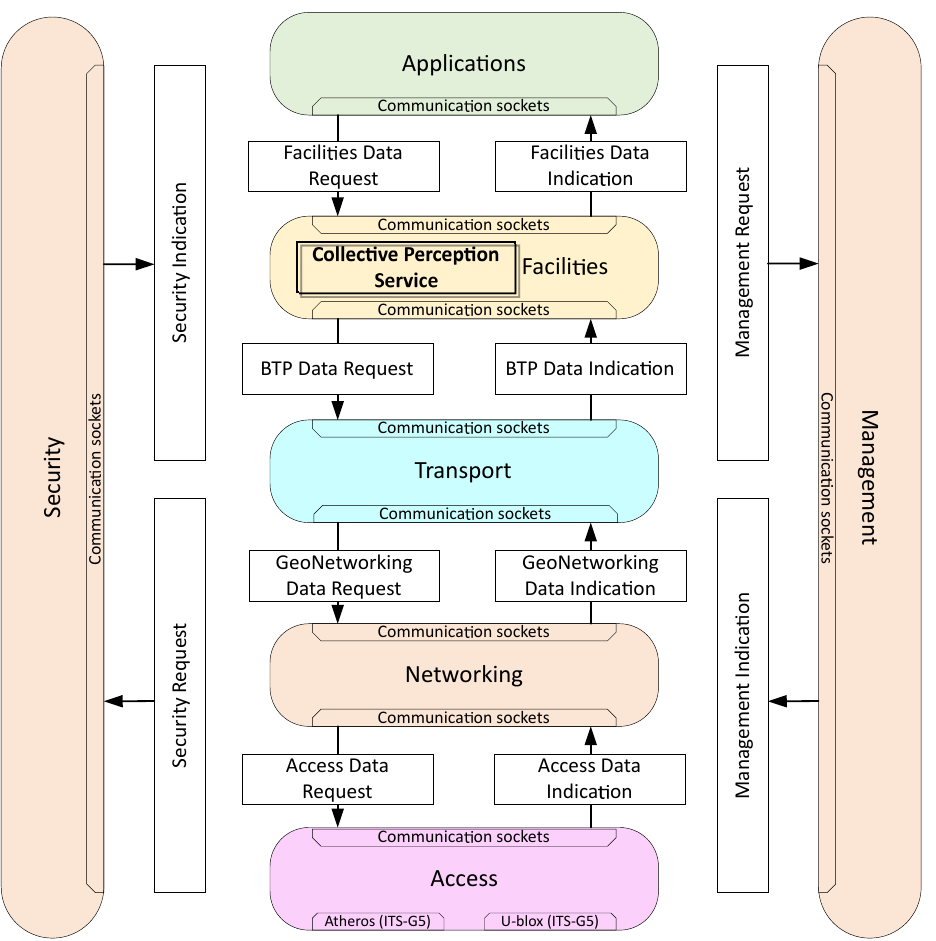
Figure 3. ITS-S protocol stack architecture and the corresponding